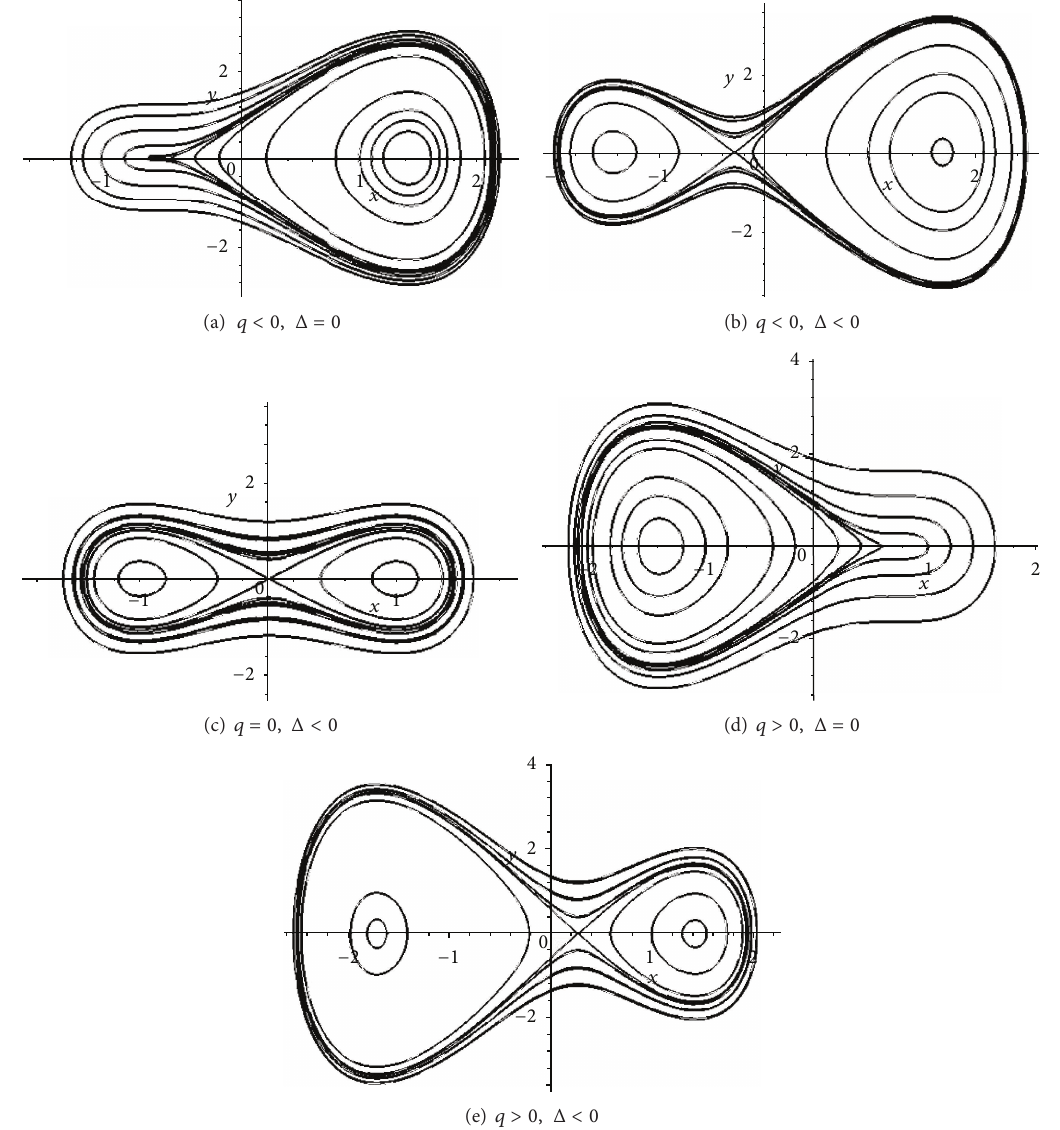
Figure 2: The phase portraits of system (9) for 𝑏 3 < 0